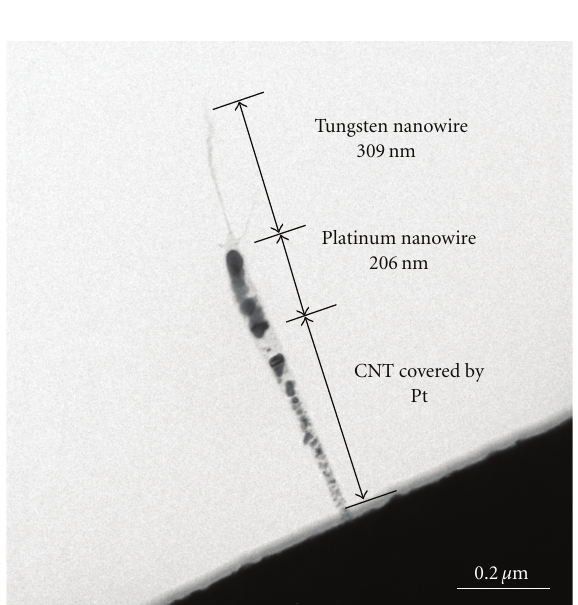
Figure 11: TEM image of hybrid nanowire growth with no distinct